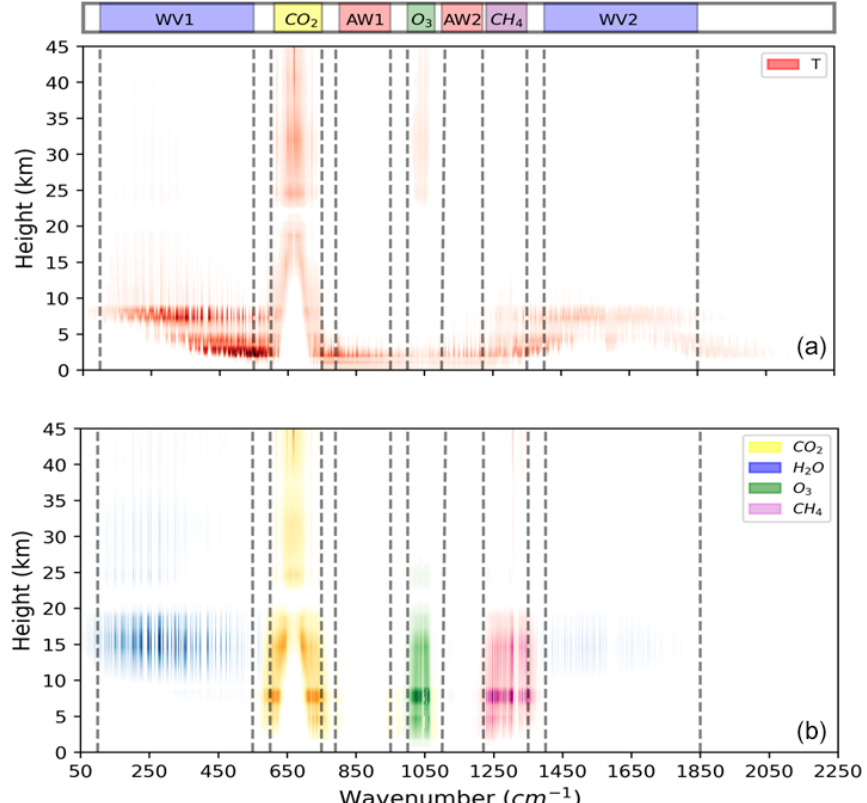
Figure 2. Absolute values of normalized Jacobians computed with σ -IASI for a tropical standard atmosphere with respect to the temperature (a) and gases concentration (b) . The N 2 O Jacobian is not shown because the CH 4 Jacobian completely overlaps it.